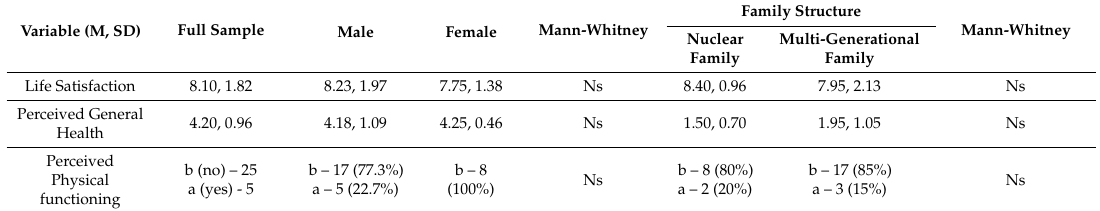
Table 2. Wellbeing Indicators including di ff erentiation according to Gender and Family